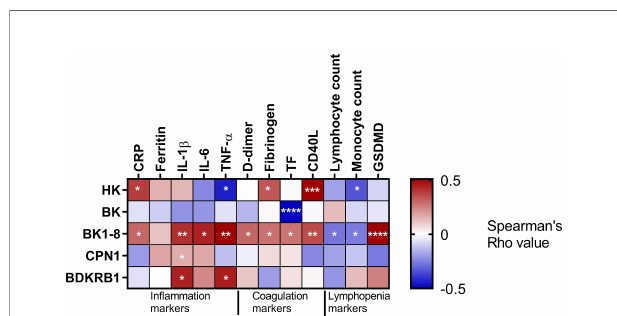
FIGURE 3 | KKS association with in fl ammation, coagulation, and lymphopenia. Heatmap representing Spearman ’ s correlation coef fi cients between BK cascade components and in fl ammation, coagulation, or lymphopenia markers. HK, high – molecular weight kininogen; BK, bradykinin; BK1-8, bradykinin1-8; CPN1 carboxypeptidase N subunit 1; BDKRB1, bradykinin receptor B1; CRP, C-reactive protein; IL, interleukin; TNF, tumor necrosis factor; TF, tissue factor, GSDMD, Gasdermin D. Signi fi cant associations are marked by asterisks. * P < 0.05; ** P < 0.01; *** P < 0.001; **** P <